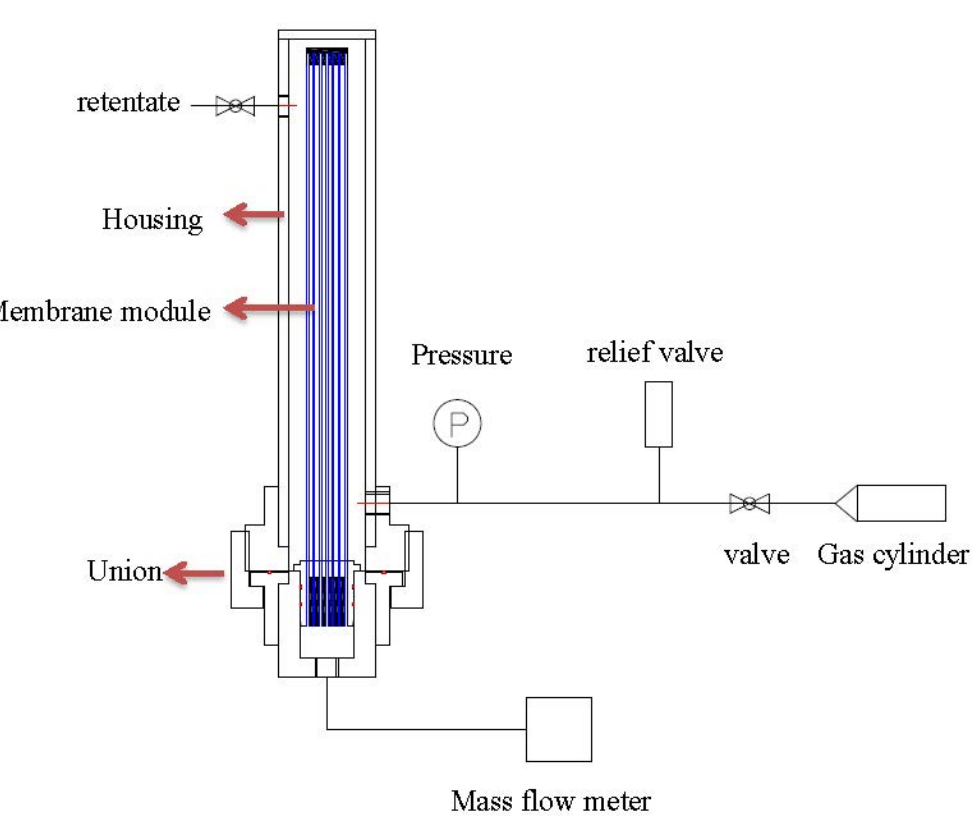
Figure 3. Pure gas test skid of hollow fiber modules.